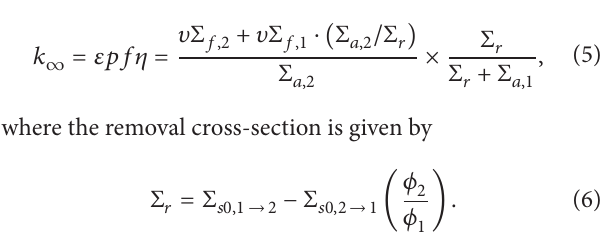
U reaction. 238 (𝑛𝑛𝑛𝑛𝑛𝑛